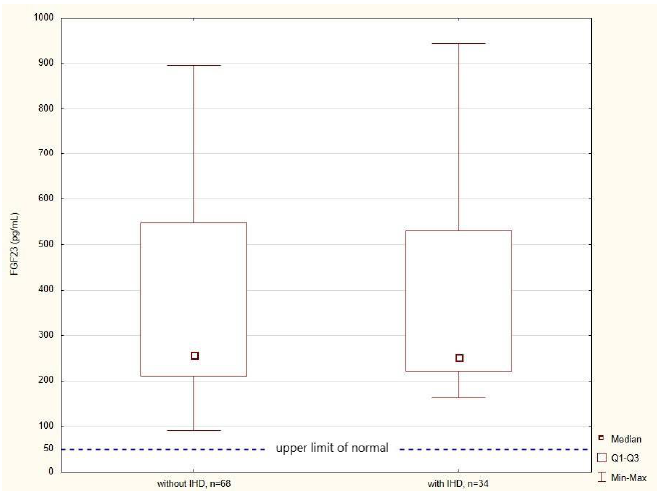
Figure 3. Box plots showing the median levels of FGF23 according to IHD status with reference to the upper limit of normal for FGF23 according to Yamazaki et al. [15]. Abbreviations: IHD, ischemic heart disease; FGF23, fibroblast growth factor 23.